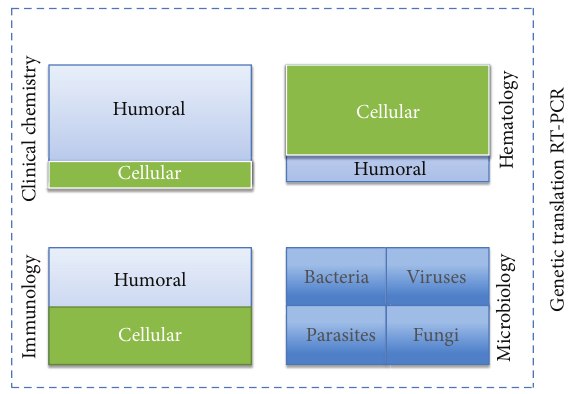
Figure 2: The four main specialities of laboratory medical analyses. The four major sections of medical laboratory analyses are shown using a four-box pattern, that is, clinical chemistry, haematology, immunology, and microbiology. Approximate quota of humoral and cellular assays is given. The big data data warehouse is substantially enlarged if each assay is completed/translated using DNA testing by real-time polymerase chain reaction (RT-PCR). Genetic embrace- ment is drawn as broken